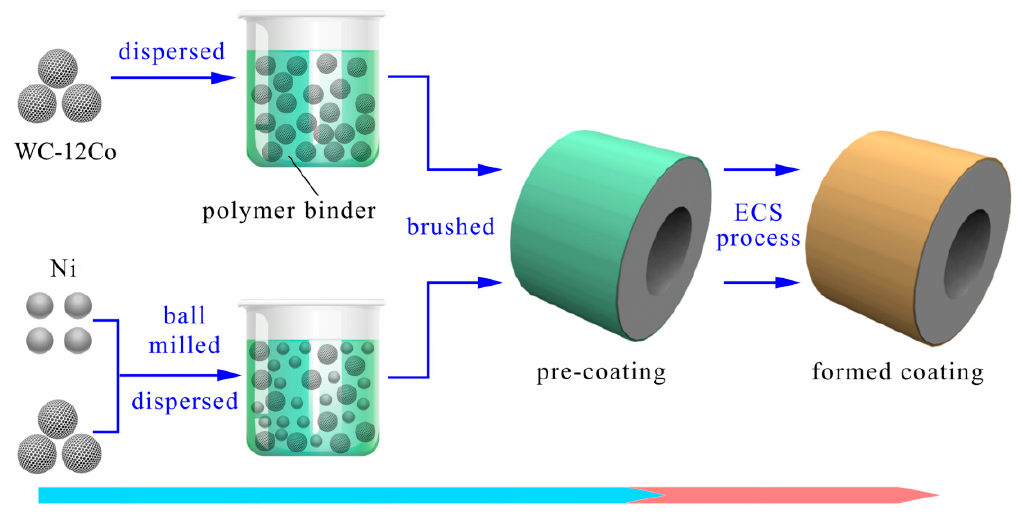
Figure 2. Coating preparation procedure.